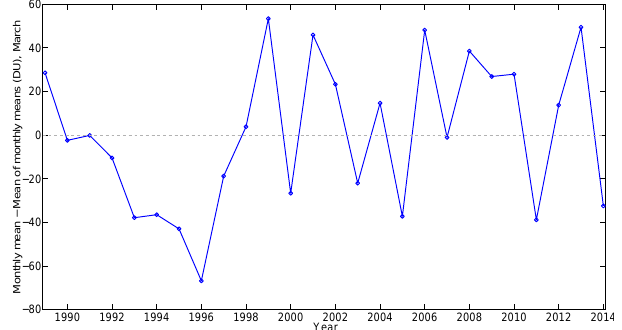
Figure 4. Ten days’ running average of daily values 1988–2014 for each day of the